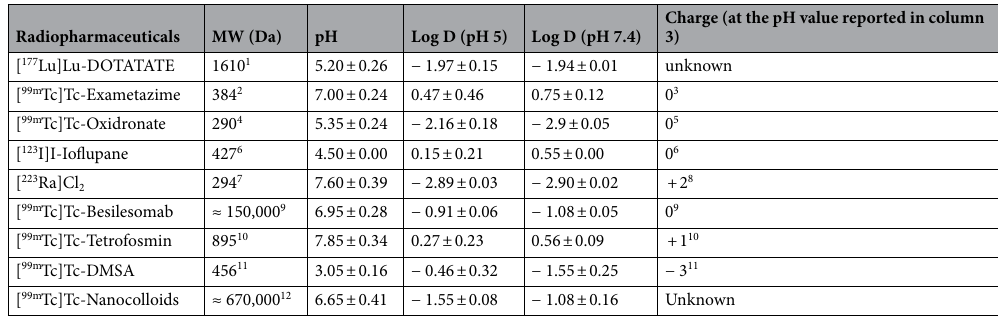
Table 3. Physicochemical properties of the radiopharmaceuticals investigated in this work. MW = molecular weight.